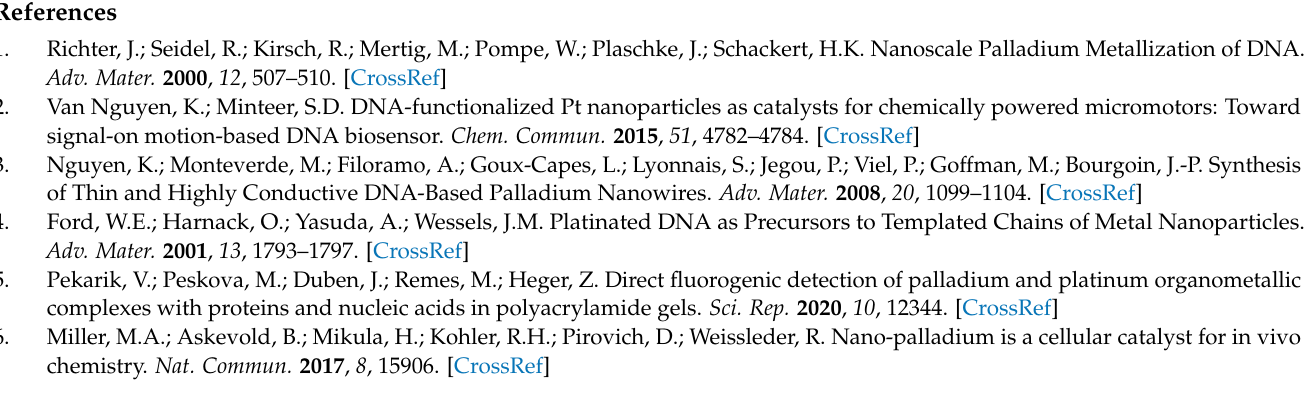
Hydrogen Bonds for 1 , Table S4: Torsion Angles for 1 , Table S5: Bond Lengths for 2 , Table S6: Bond Angles for 2 , Table S7: Hydrogen Bonds for 2 , Table S8: Torsion Angles for 2